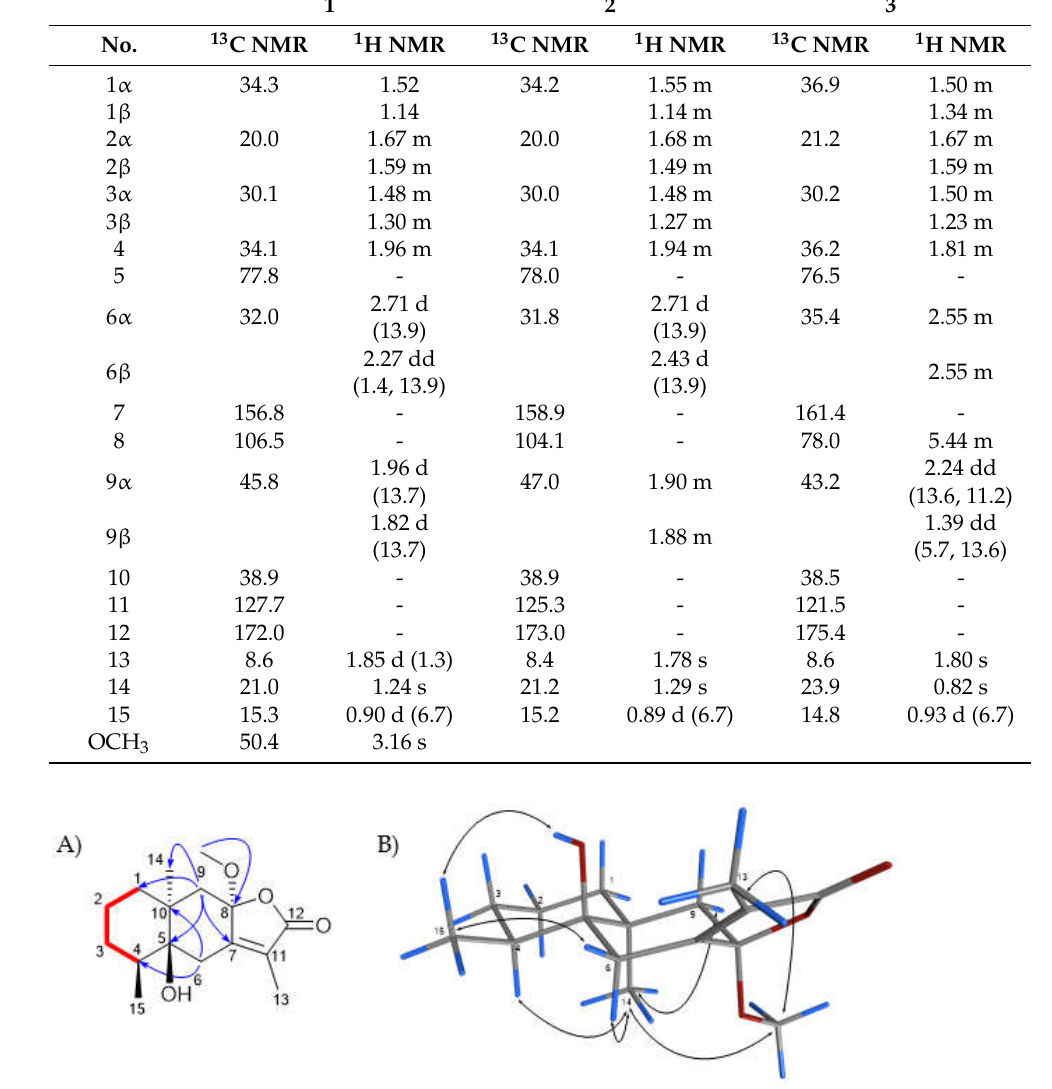
Figure 2. ( A ) Key COSY (red bold bonds) and HMBC (blue arrows) correlations ( B ) NOESY (double headed arrows) correlations observed for compound 1. Table 1. NMR data for the three isolated ermiasolides from C. megalocarpus in CDCl 3 ( J in Hz).